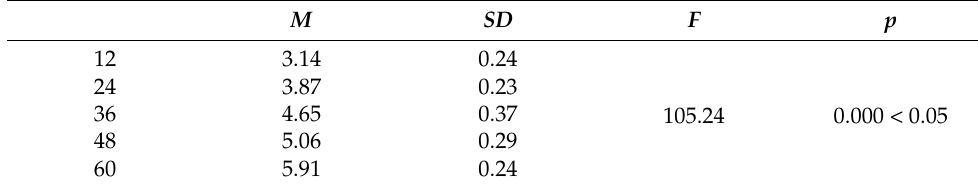
Table 4. Time statistic value under intensity